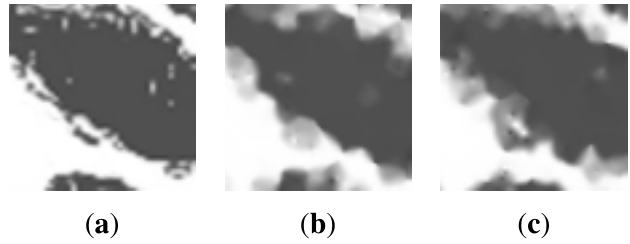
Figure 11. A section from Figures 8 and 10a,b respectively.